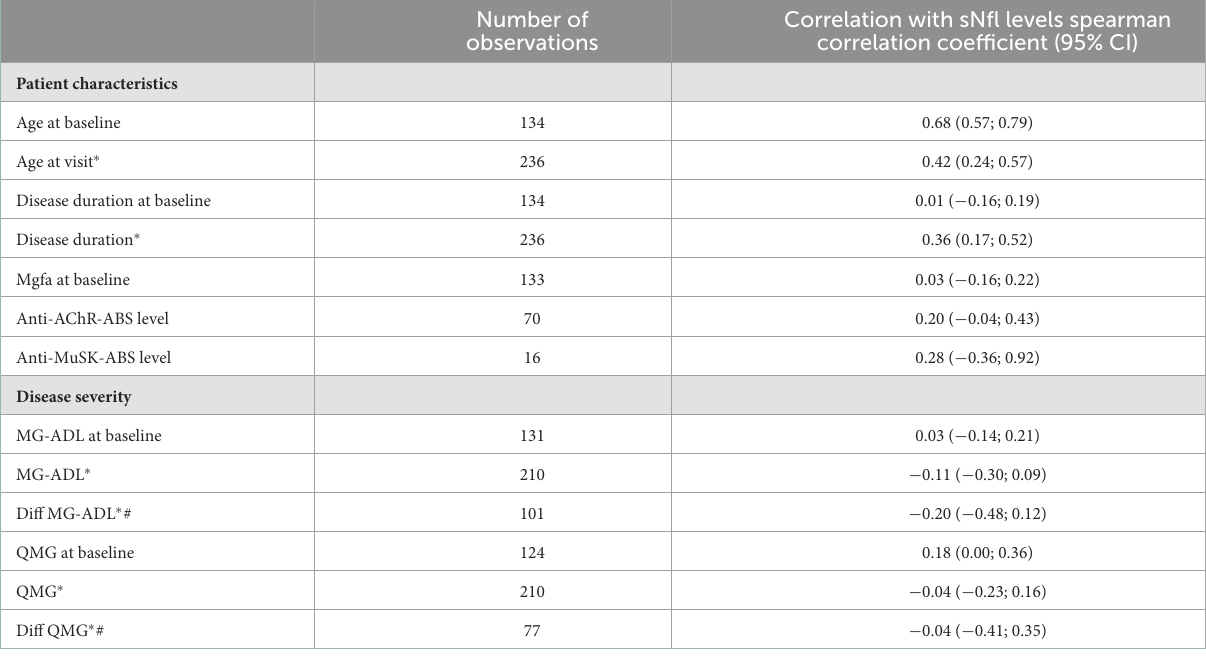
TABLE 2 Spearman correlation coefficients for the association of patient characteristics and sNfl levels. Number of